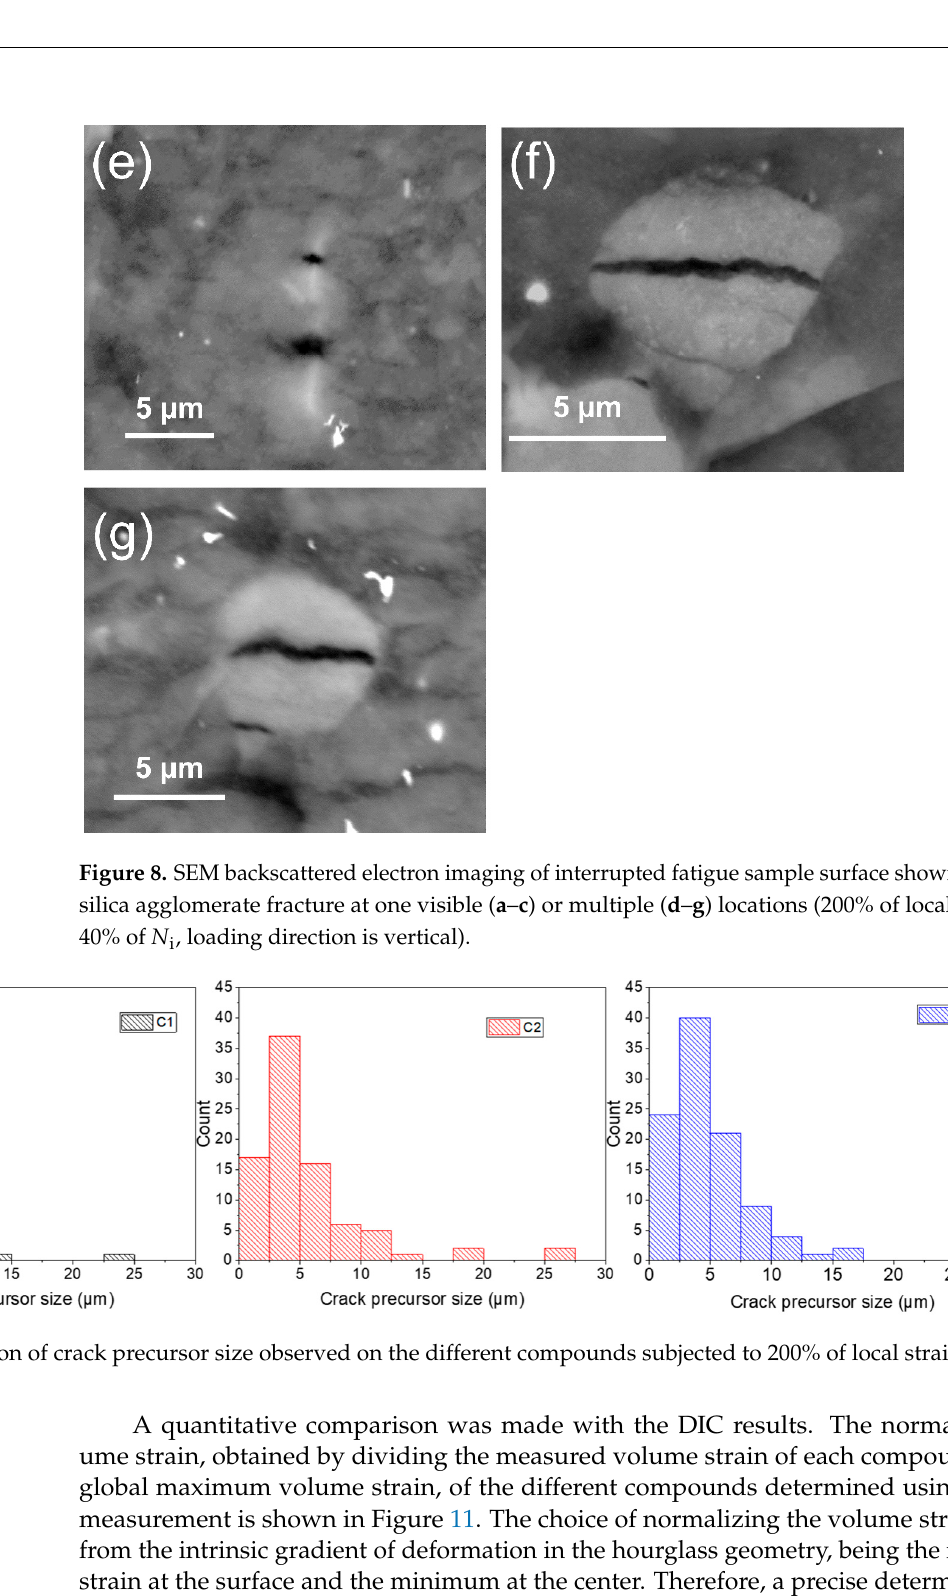
Figure 10. Volume fraction of cracks versus percentage of end of life using µCT. A quantitative comparison was made with the DIC results. The normalized volume strain, obtained by dividing the measured volume strain of each compound by the global maximum volume strain, of the different compounds determined using 3D-DIC measure- ment is shown in Figure 11. The choice of normalizing the volume strain comes from the intrinsic gradient of deformation in the hourglass geometry, being the maximum strain at the surface and the minimum at the center. Therefore, a precise determination of the de- formation is not ensured with the current method, inducing experimental bias in calculat- ing the volume strain. By normalizing, we propose to discuss the overall trends of the